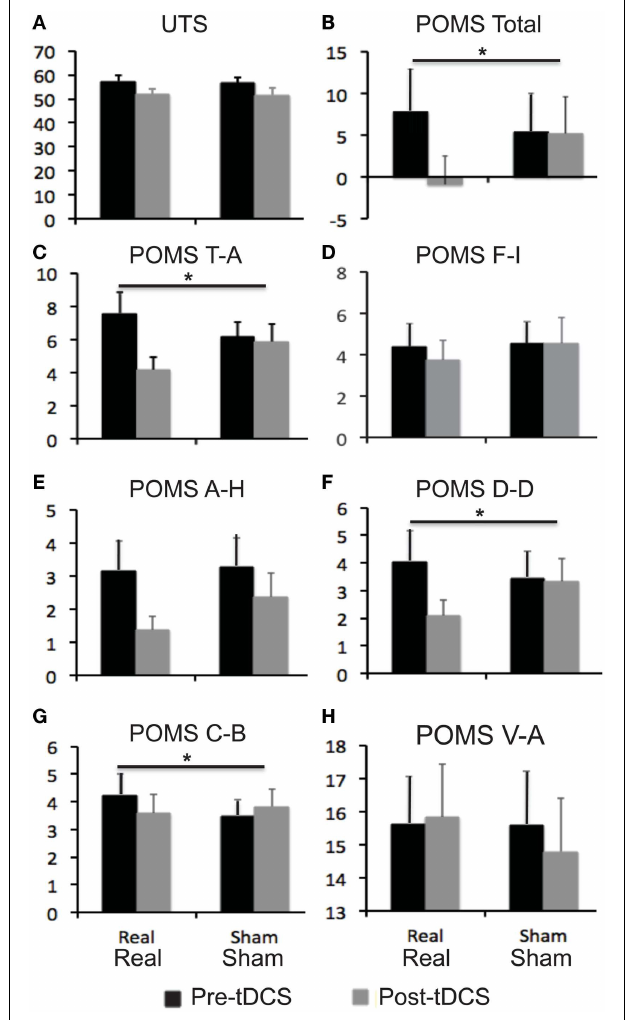
FIGURE 2 | Self-reported scores on mood and craving for smoking . Bar graphs show self-reported scores on urge to smoke (UTS) scale and profile of mood state (POMS). (A) UTS scores; (B) POMS total scores; (C–H) scores for six subscales of POMS. Error bars indicate standard